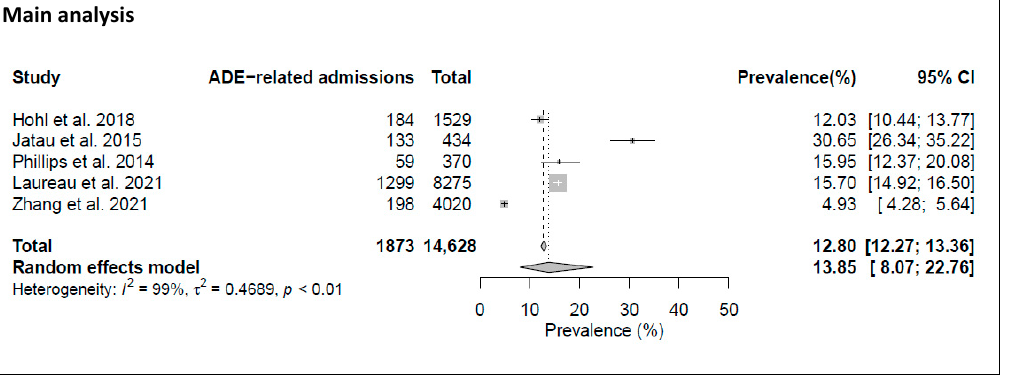
Figure 2. Main analysis. Forest plot of the pooled prevalence of ADR-related admissions to EDs or inpatient wards [5,27–32,37,38,40,41,43] .